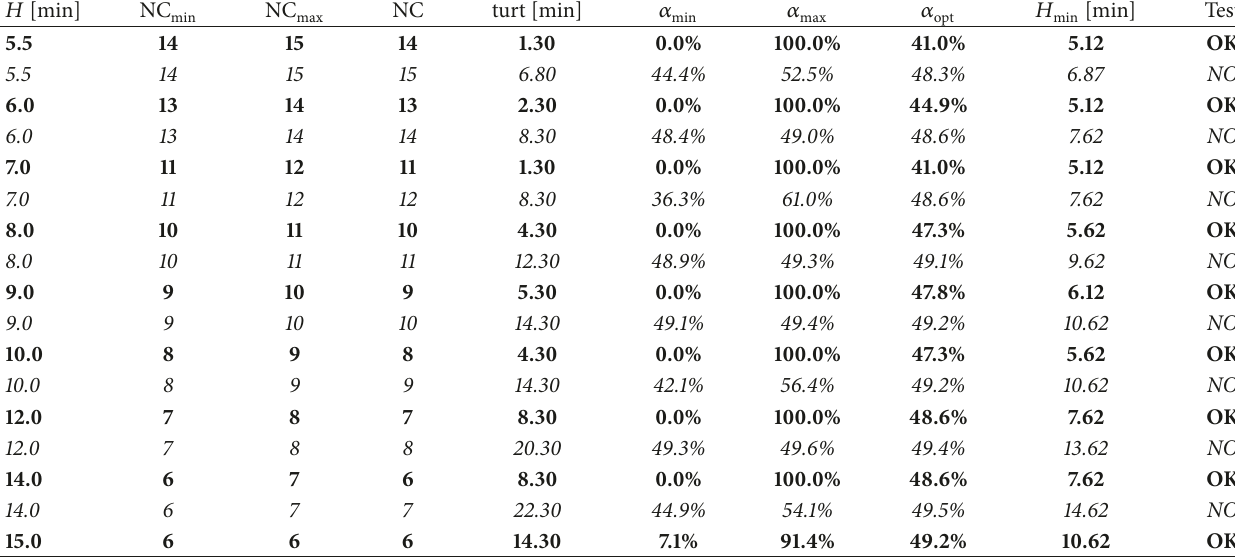
Table 3: Feasible configuration calculation in the case of the 90th percentile.